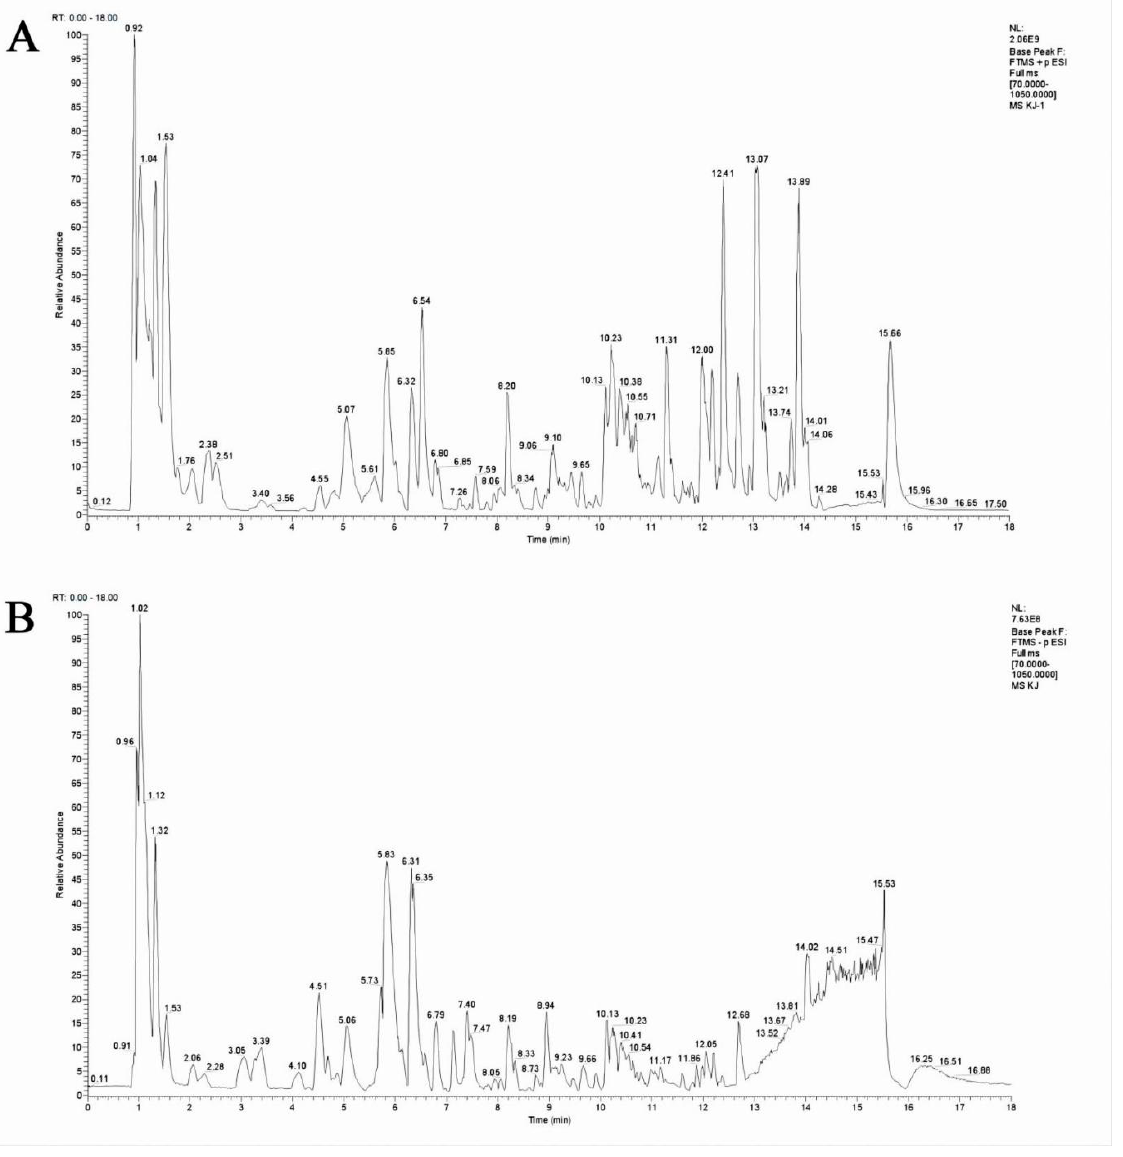
Figure 1. The total ion chromatogram of QLJP. ( A ) positive ion mode and ( B ) negative ion mode.